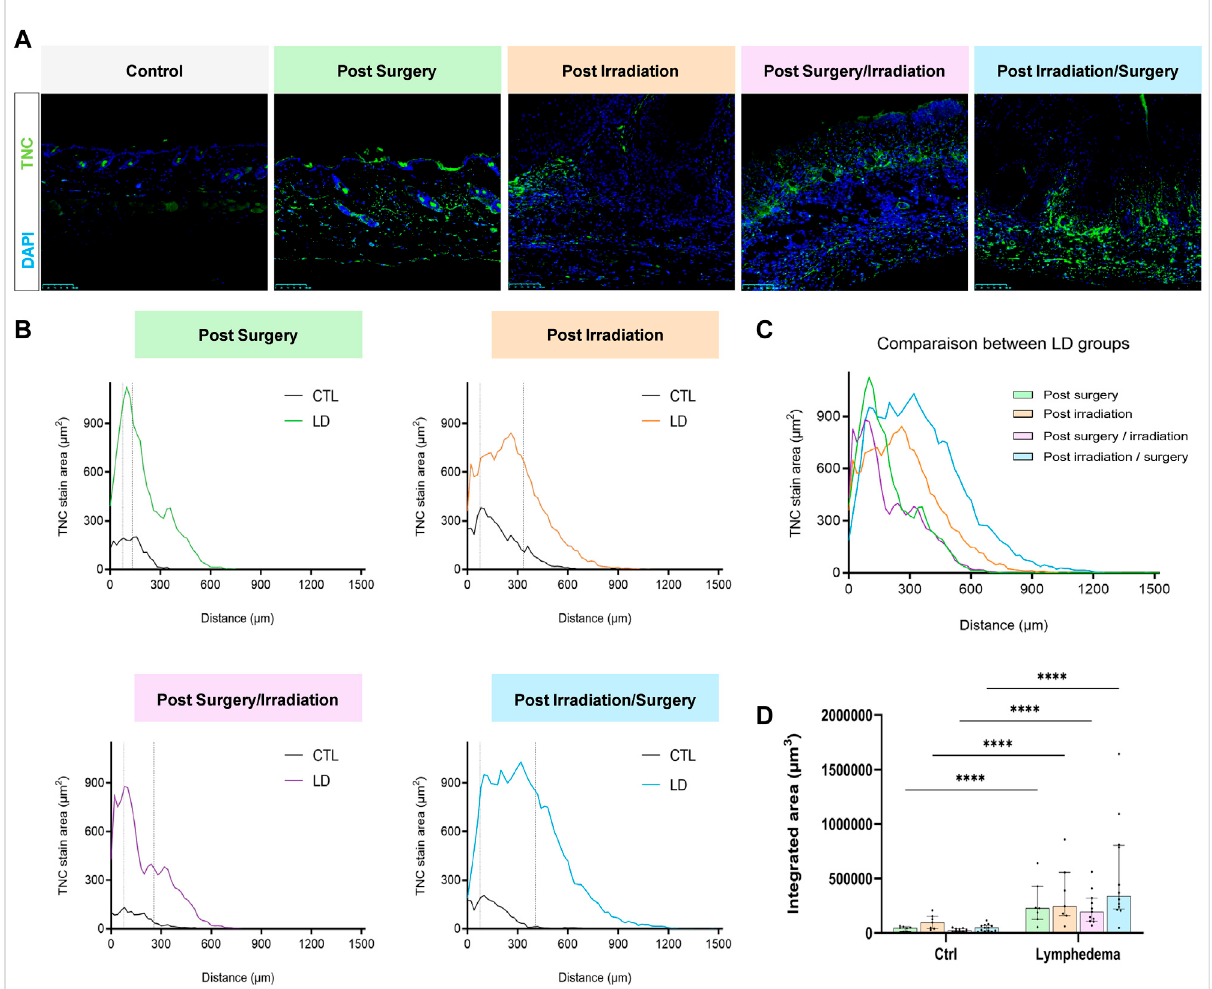
FIGURE 7 Impact of the procedures on TNC deposition. (A) Representative images of TNC area staining in control and LD skins (Scale bar: 100 µm). (B) Spatial distribution of TNC within the dermis (0 on the x -axis is the junction between dermis and epidermis). The dotted line delineates the junction between papillary (PD) and reticular (RD) dermis. (C) Comparison of the distribution of TNC staining area between experimental groups. (D) Quanti fi cation of total labeling area in thedermisdetermined by measuring the area under the distributions curve ( “ Integrated Area ” )(Statistical test: two-way ANOVA with multiple comparison Turkey ’ s test, p < 0.05: *, p < 0.01: **, p < 0.001: ***, p < 0.0001: